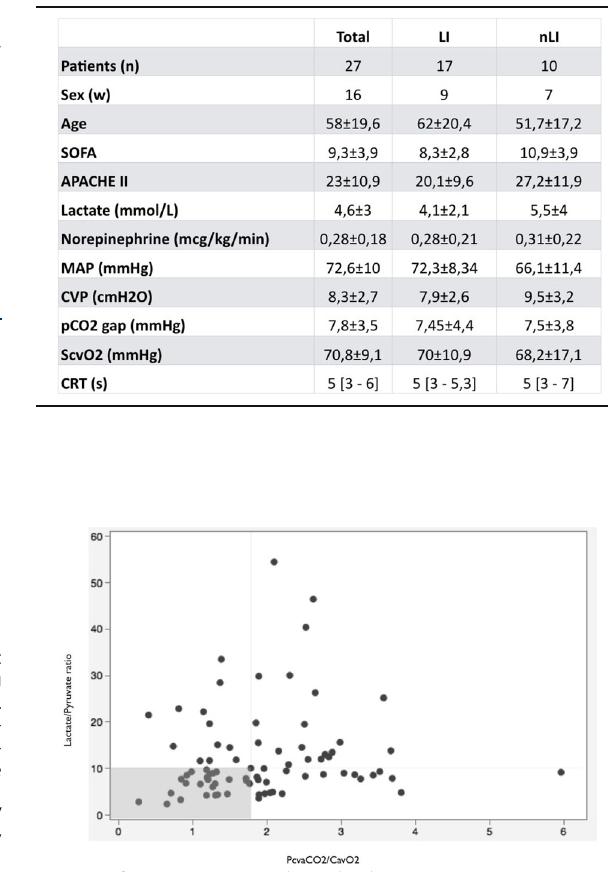
Fig. 1 (abstract 000305). Relationship between Lactate/Pyruvate and PcvaCO2/CavO2. Dotted lines: normal limits (L/P<10, PcvaCO2/ CavO2<1.8), grey shaded area: normal range. No statistical correlation was found ( r =0,11; p